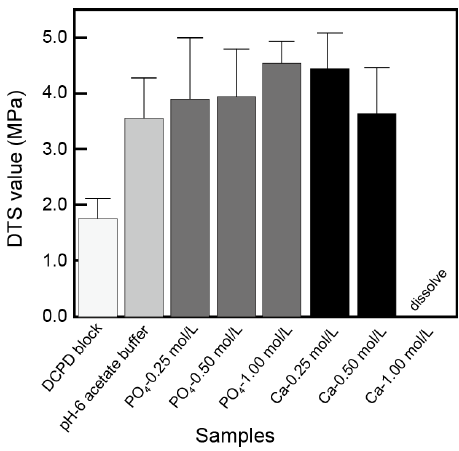
Figure 5. Diametral tensile strength (DTS) values of the DCPD block before and after immersion in a pH-6 acetate buffer solution with PO 4 or Ca at 70 °C for 2 days.